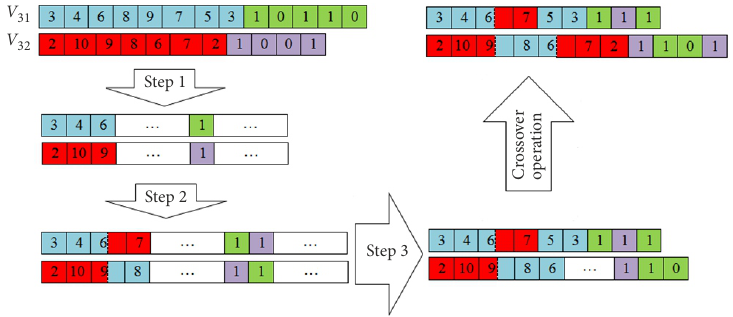
Figure 7. Example of the proposed heuristic crossover operator